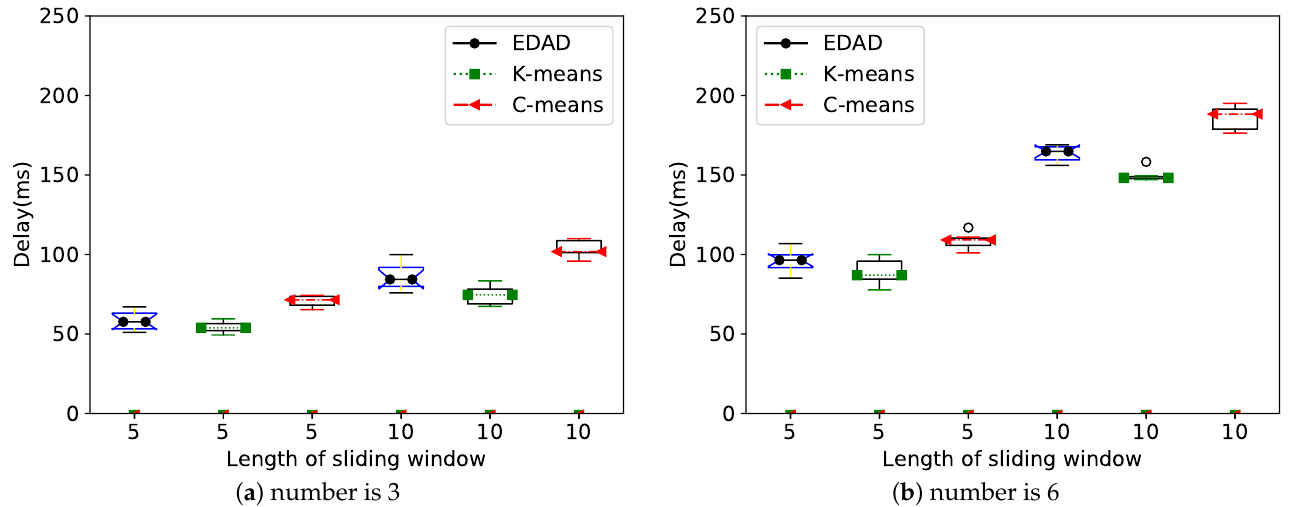
Figure 9. Delay experiment result under different sliding window lengths and different sensor numbers. Figure 9a,b test the delay changes under different sliding window lengths.